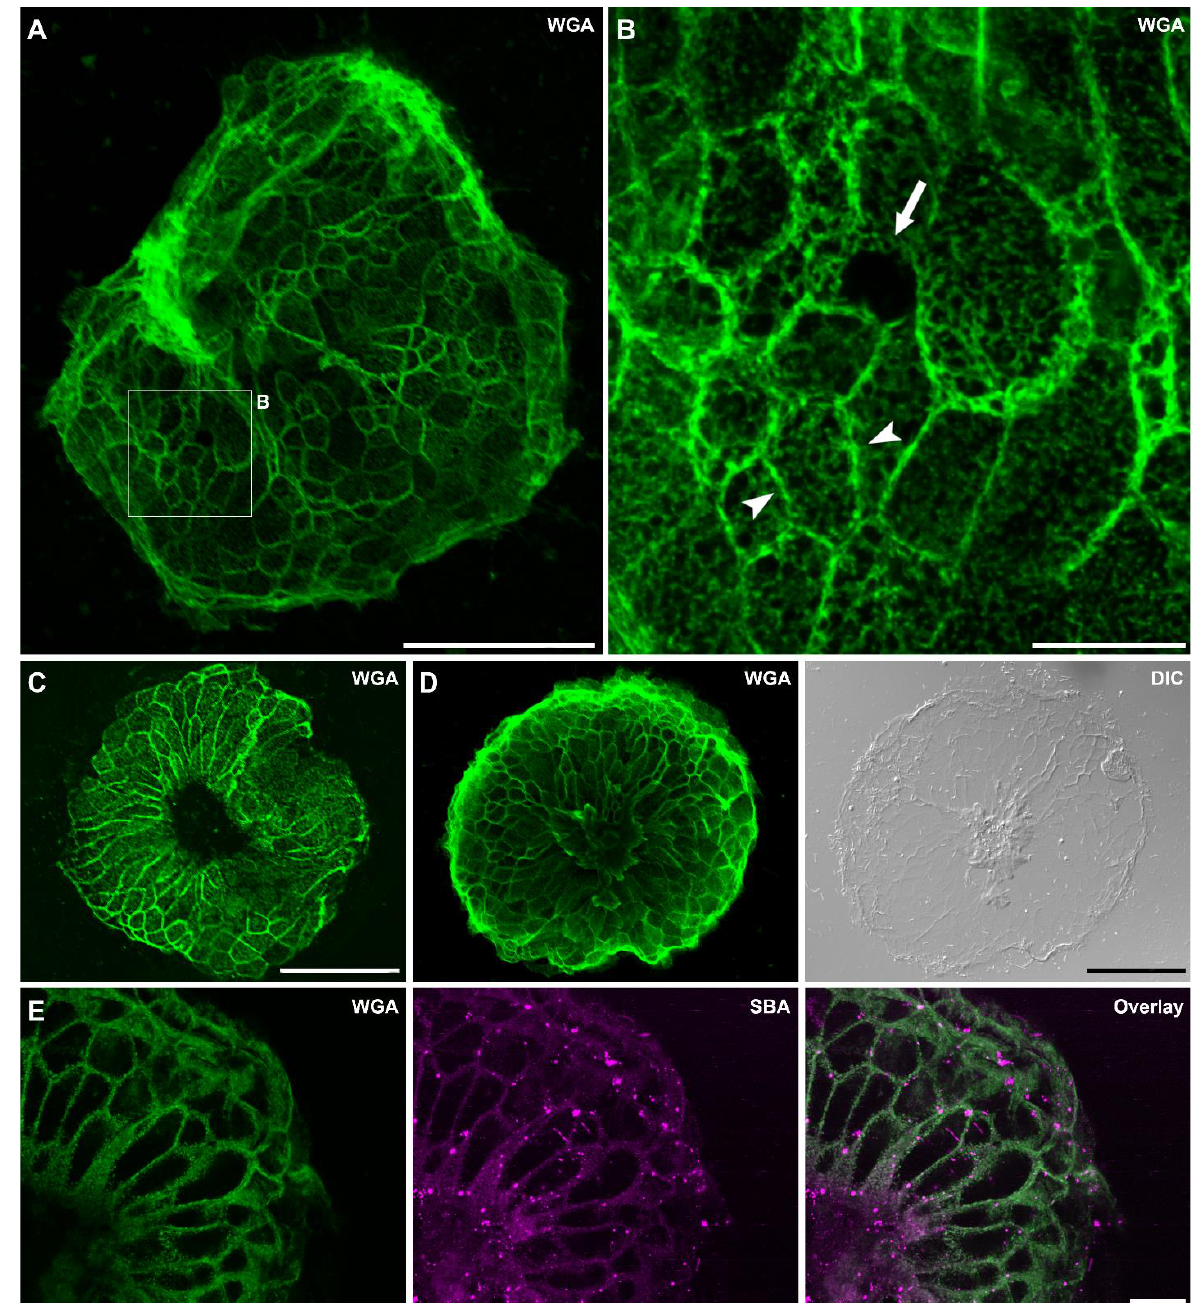
Figure 3. Lectin labeling of Hydra footprints with WGA ( A – D ) and SBA/WGA double labeling ( E ). ( A ) Footprint overview. ( B ) Footprint structure at a higher magnification; note the meshwork-like appearance. Arrowheads highlight the imprint of the basal disc cell borders and the arrow indicates a hole in the footprint. ( C ) Footprint with an empty area in the middle and ( D ) discarded cells at the same position. (E) Footprint detail of SBA and WGA double staining, note that the staining overlaps. Scale bars: ( A , C , D ) 100 µ m; ( B , E ) 20 µ